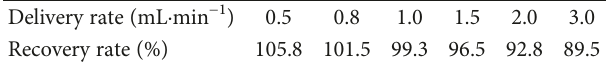
Table 3: Results of di ff erent delivery rates of titrant.